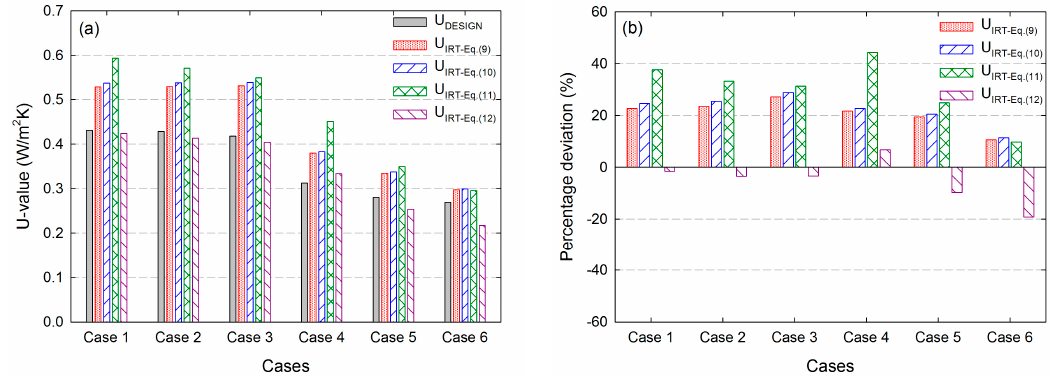
Figure 8. ( a ) U -values; ( b ) their percentage deviations estimated by calculation method and infrared thermography method.